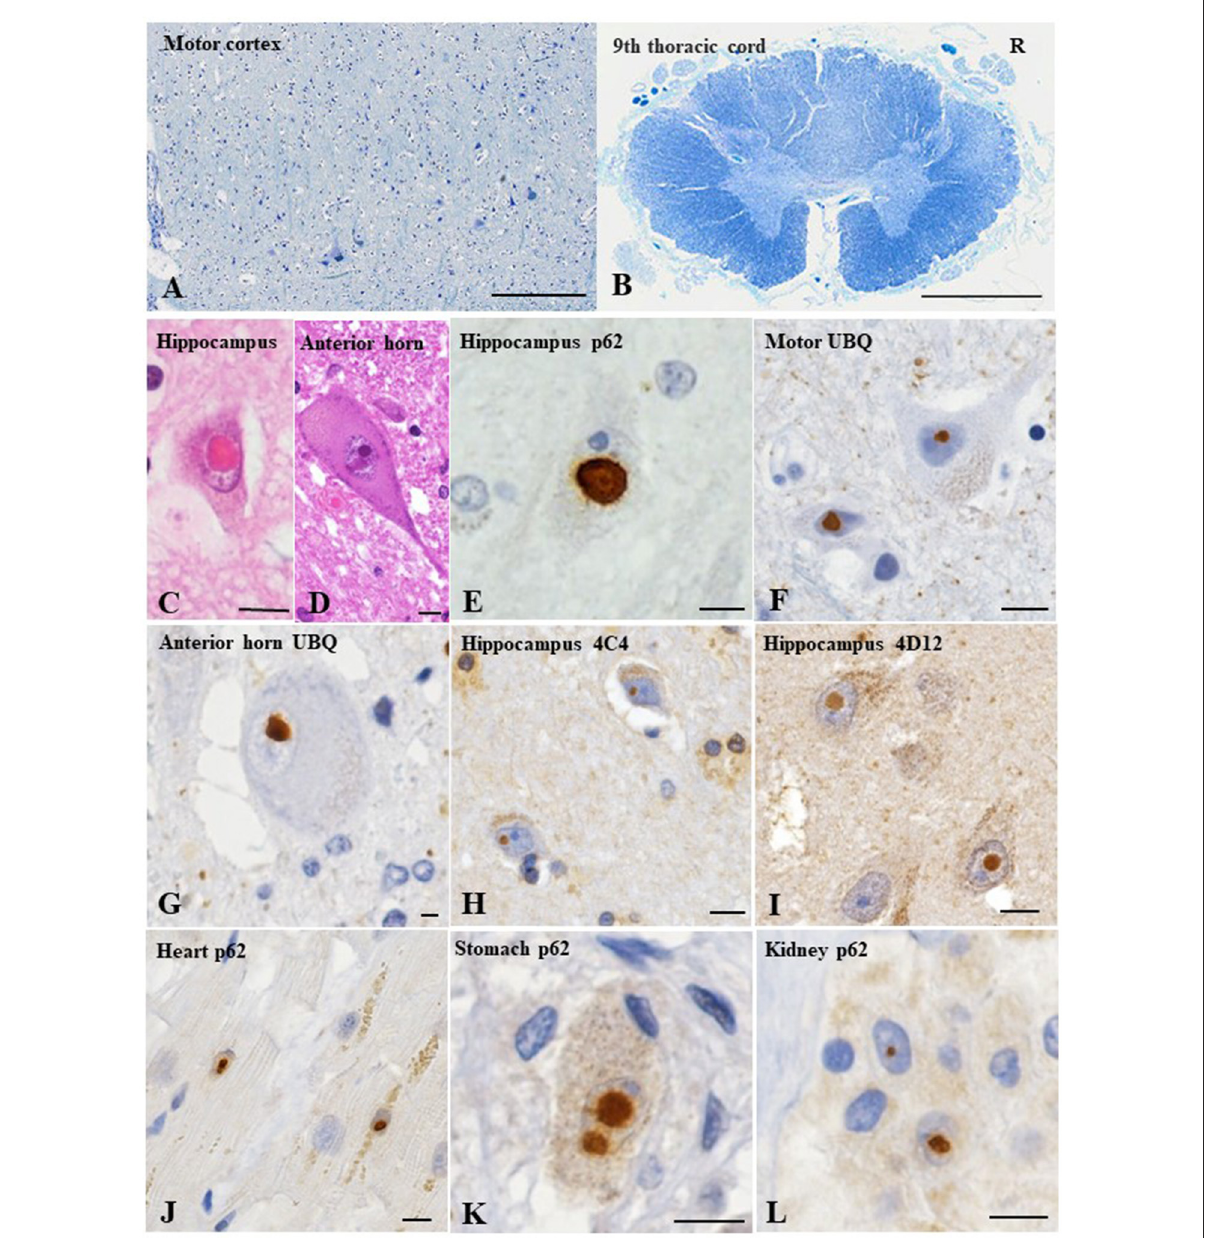
FIGURE2 Pathological findings of the present case. The motor cortex shows slight loss of neurons (A) . Thoracic spinal cord shows myelin pallor of the lateral corticospinal tract bilaterally, more apparent on the right side (R), reflecting the left thalamic hemorrhage (B) . Hematoxylin and eosin staining reveals an eosinophilic, round, neuronal intranuclear inclusion in the hippocampus (C) and anterior horn of the lumbar cord (D) . Immunohistochemical evaluations reveal ubiquitin- and p62-immunopositive neuronal intranuclear inclusions in the hippocampus (E) , motor cortex (F) and spinal anterior horn (G) . In addition, uN2CpolyG immunoreactivity is confirmed by two specific antibodies (4C4 and 4D12) (H, I). p62-positive neuronal intranuclear inclusions are evident in the cardiac muscle cells (J) , Auerbach’s plexus of the stomach (K) , and renal tubule epithelial cells (L) . Klüver–Barrera staining (A, B) ; p62 (E, J–L) ; ubiquitin (F, G) ; uN2CpolyG (4C4) (H) ; uN2CpolyG (4D12) (I) . Bars = 100 µ m (A) , 2mm (B) , and 10 µ m (C–L) .